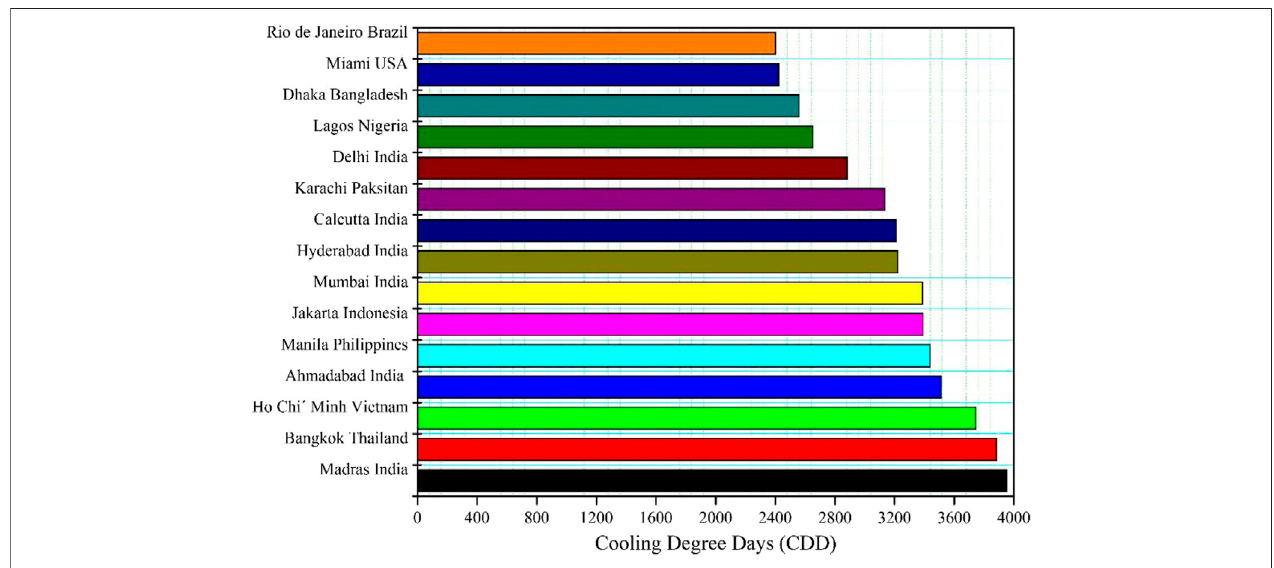
FIGURE 9 | Top 15 metropolitan areas with respect to Cooling Degree Days (CDD) Data Source: (Sivak, 2009).